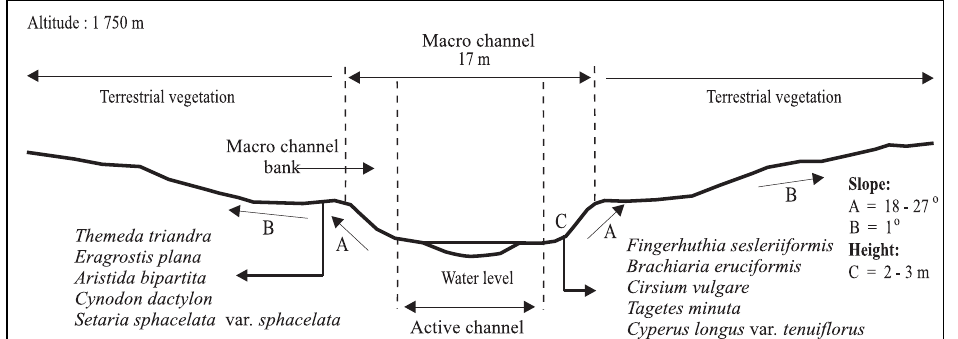
Fig. 3. River profile of the Themeda triandra-Fingerhuthia sesleriiformis